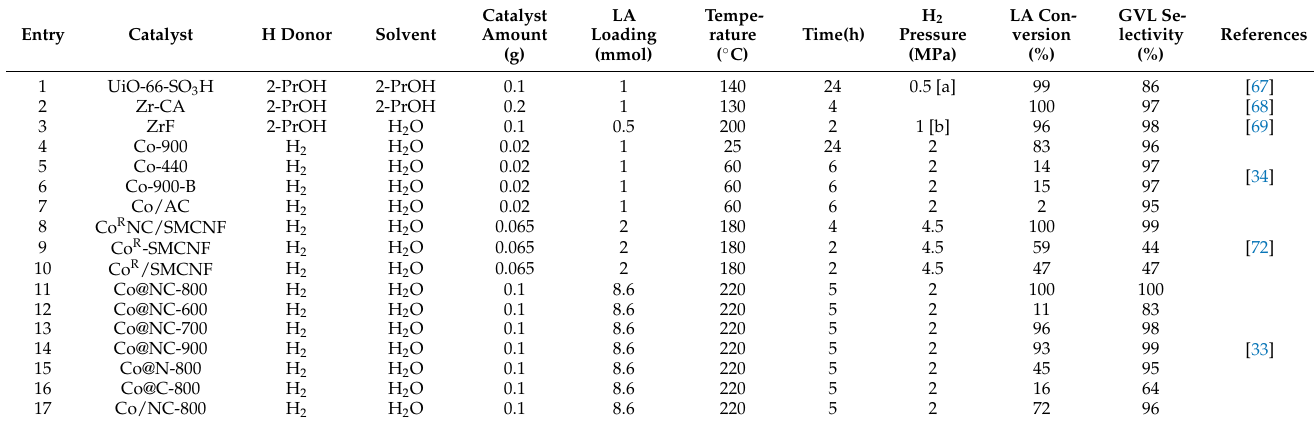
Table 3. Non-precious metal–heteroatom catalysts for the hydrogenation of LA to GVL.